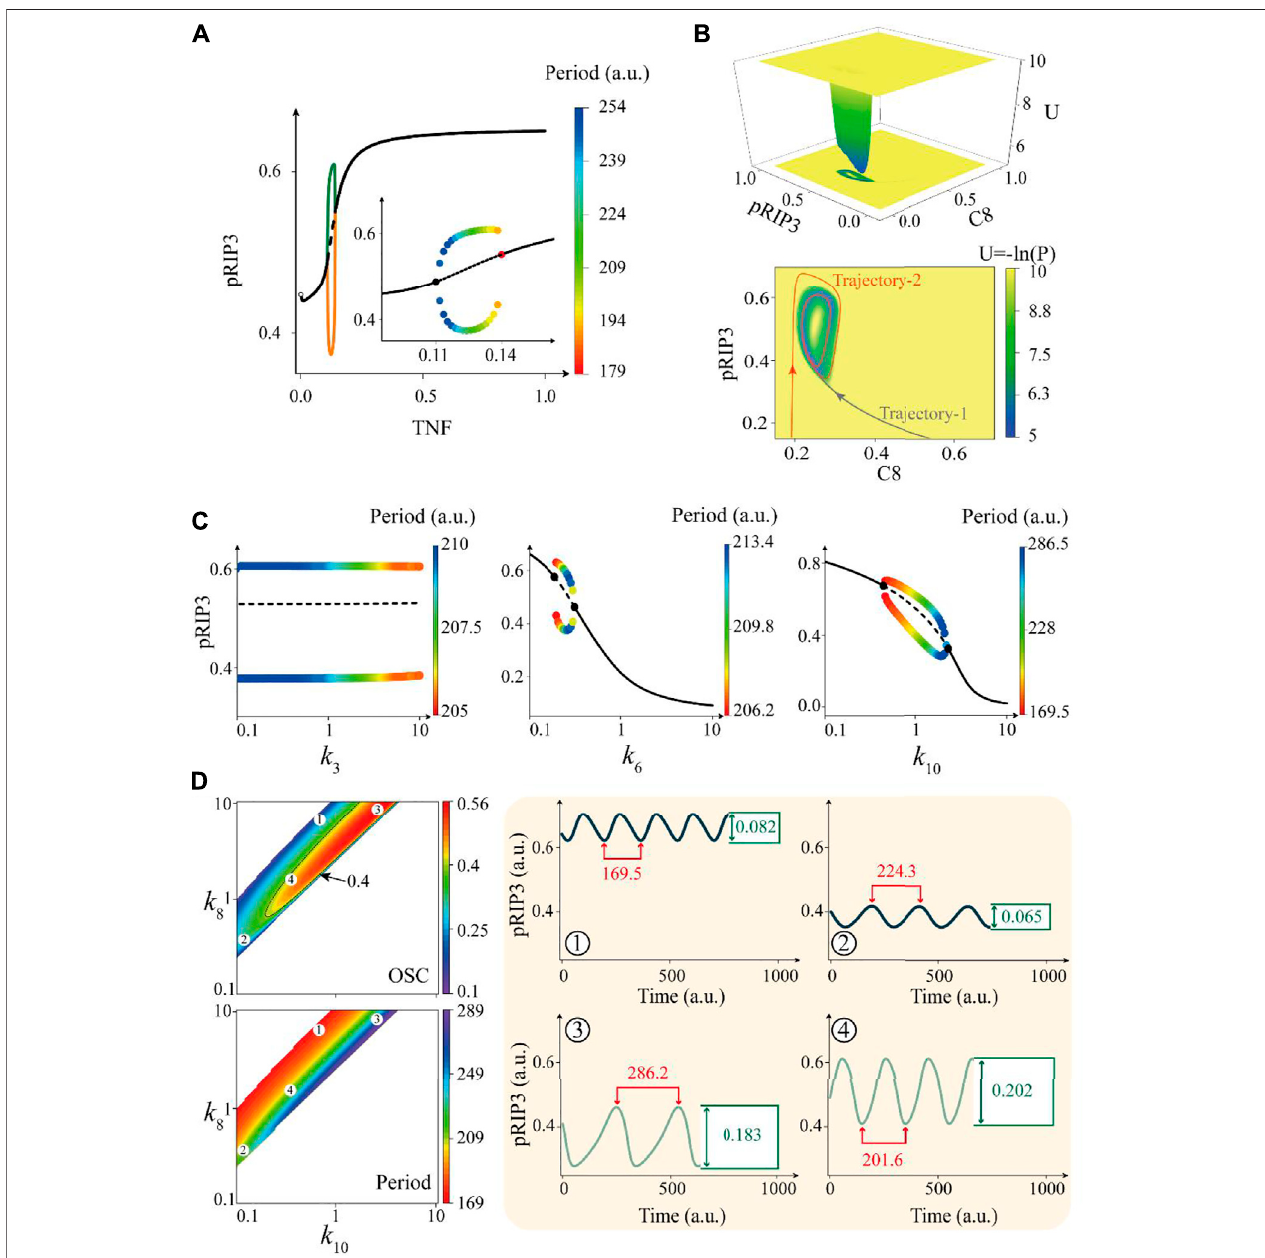
FIGURE 6 | Oscillation dynamics and bifurcation behavior of an example of deterministic CNS circuit. (A) Bifurcation diagram of TNF stimulation strength in a deterministic circuit. The solid and dashed black lines respectively represent the stable and unstable equilibrium points of the system, the colored lines represent the extremes of the oscillations, and the colors of the dots in the sub- fi gure represent the periods. (B) Landscape of the CNS system with an annular potential well, and the two-dimensional phase diagram in the lower panel has two typical evolution trajectories. (C) Bifurcation diagrams of three representative parameters within the unidirectional bias of the circuit. (D) The phase diagram of k 8 -k 10 two-dimensional parameter space, the upper and lower panels on the left respectively indicate amplitude and period, and the warm color indicates high amplitude and fast period oscillation behavior. The four typical time series on the right panel correspond to the four points in the phase diagram, where the values of (k 8 , k 10 ) are (8.0, 0.68), (0.29, 0.12), (9.5, 3.5), and (1.5, 0.3) respectively.